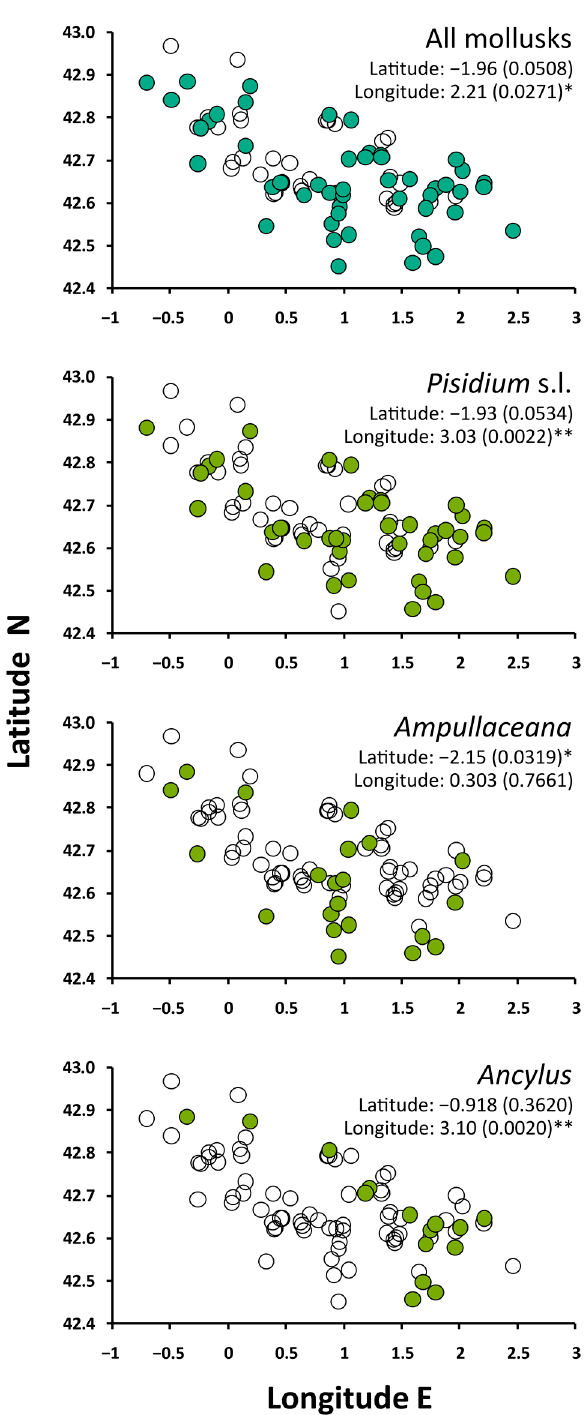
Figure 3. Spatial distribution of mollusks across the survey lakes. Significance refers to Mann– Whitney tests comparing latitude and longitude values between lakes with (filled circles) and without (empty circles) the taxon of interest. Asterisks indicate the level of signi fi cance: *, p < 0.05; **, p < 0.01.